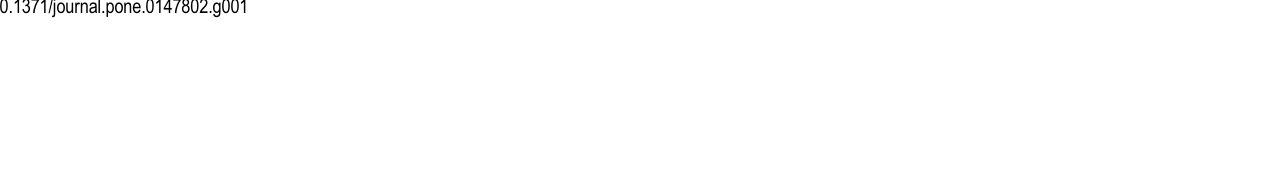
PLOS ONE | DOI:10.1371/journal.pone.0147802 January 25,